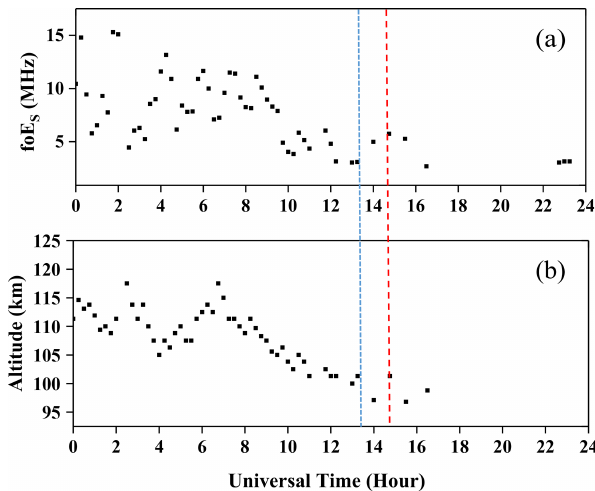
Figure 2. Sporadic E layers observed by the ionosonde at Wuhan (30.5 ◦ N, 114.6 ◦ E). (a) The time series of the critical frequency for E S ( fo E S ). The E S layers travel/propagate downward start- ing around 06:30UT and decreases to a minimum value at about 13:20UT. (b) The visual height of E S ( h (cid:48) E S ). The blue dotted ver- tical line shows the beginning of the Na S around 13:20UT, and the red dashed vertical line indicates the time when the most intense sodium enhancement starts at